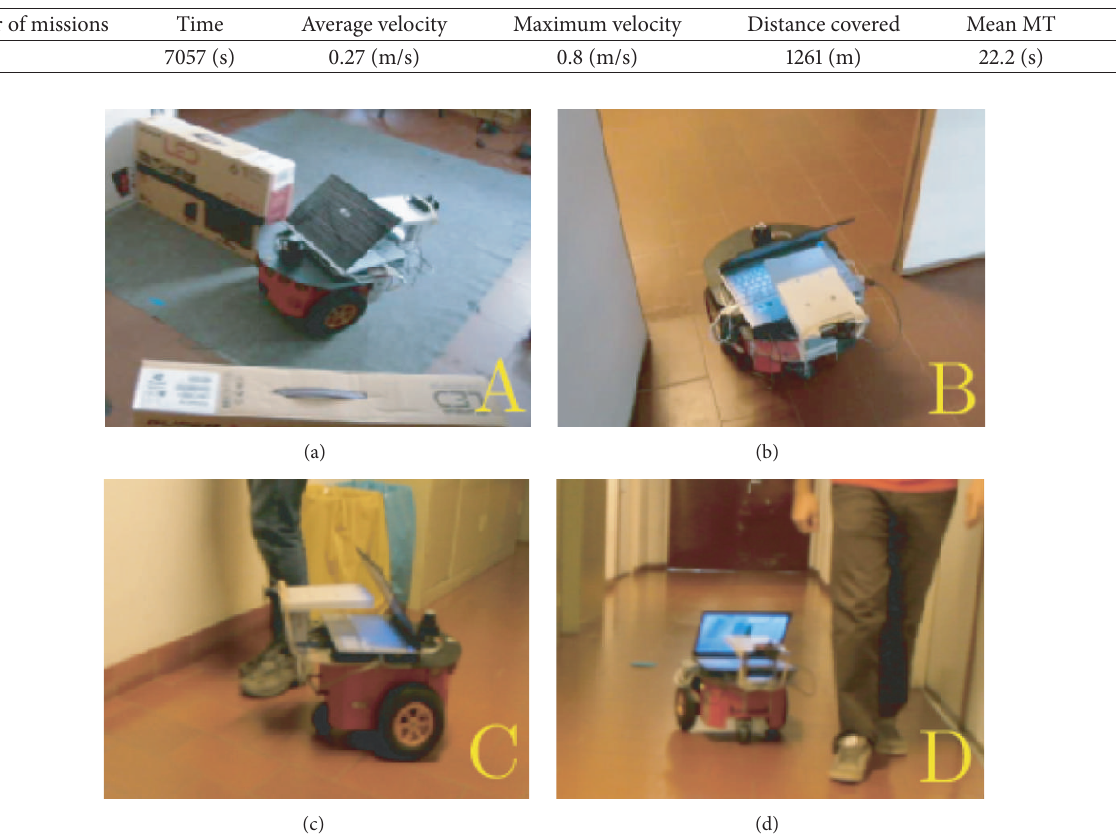
Table 2: Results of the sequential missions performed in experiment 4.